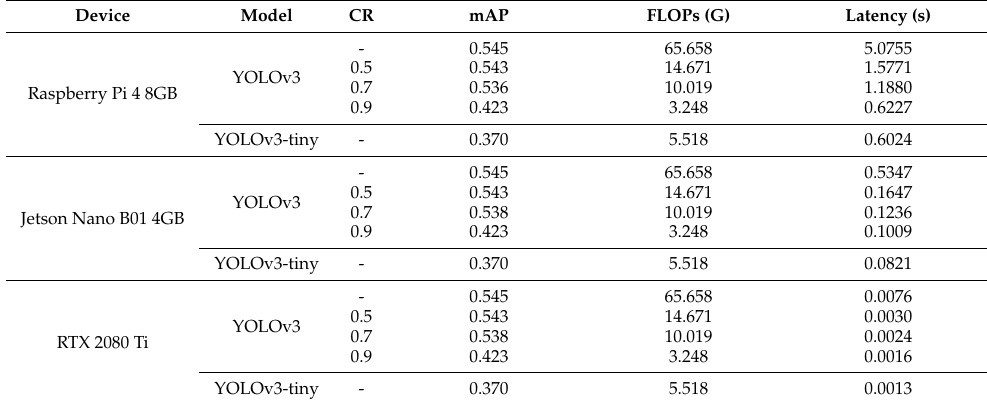
Table 5. Latency comparison between YOLOv3 and YOLOv3-tiny on various devices. Here, “Latency” is calculated as the average processing time on CIFAR-10 evaluation